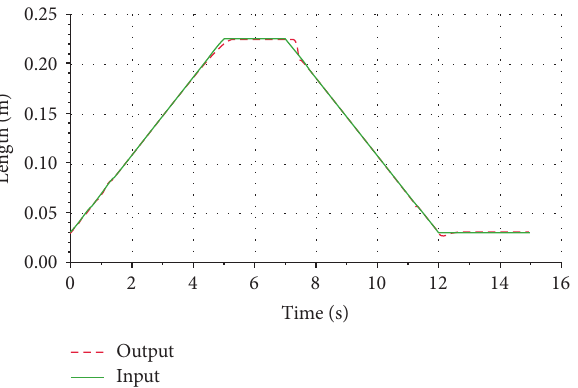
Figure 17: The relationship curve of input and output of steer angle changing with time under the steering speed 20 ∘ /s.